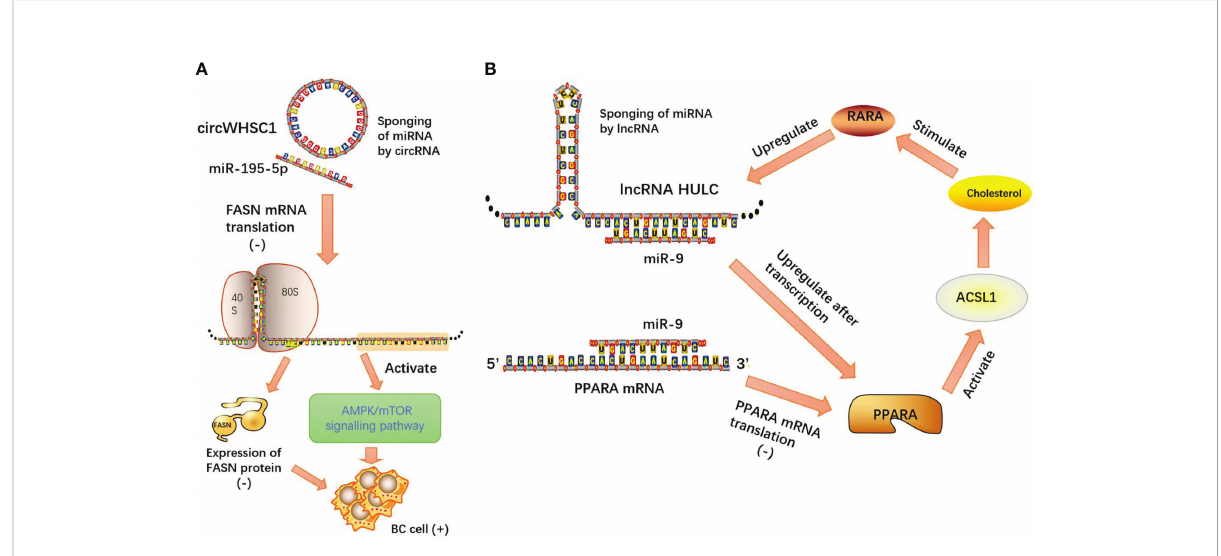
FIGURE 5 (A) CircWHSC1 acts as a competitive endogenous RNA by sponging miR-195-5p, and miR-195-5p directly targets FASN mRNA. miR-195-5p overexpression inhibits FASN expression and activates its downstream AMPK pathway; (B) lncRNA HULC forms a positive feedback loop to promote adipogenesis and enhance tumor proliferation through the HULC/miR-9/PPARA/ACSL1/cholesterol/RXRA/HULC